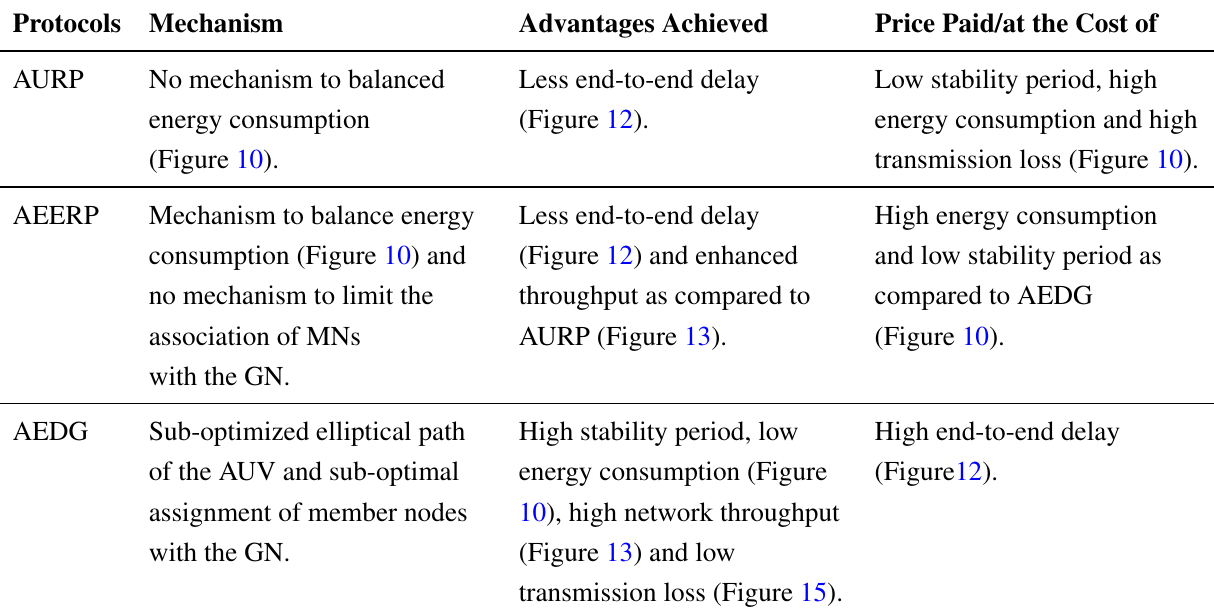
Table 3. Performance trade-offs made by the routing